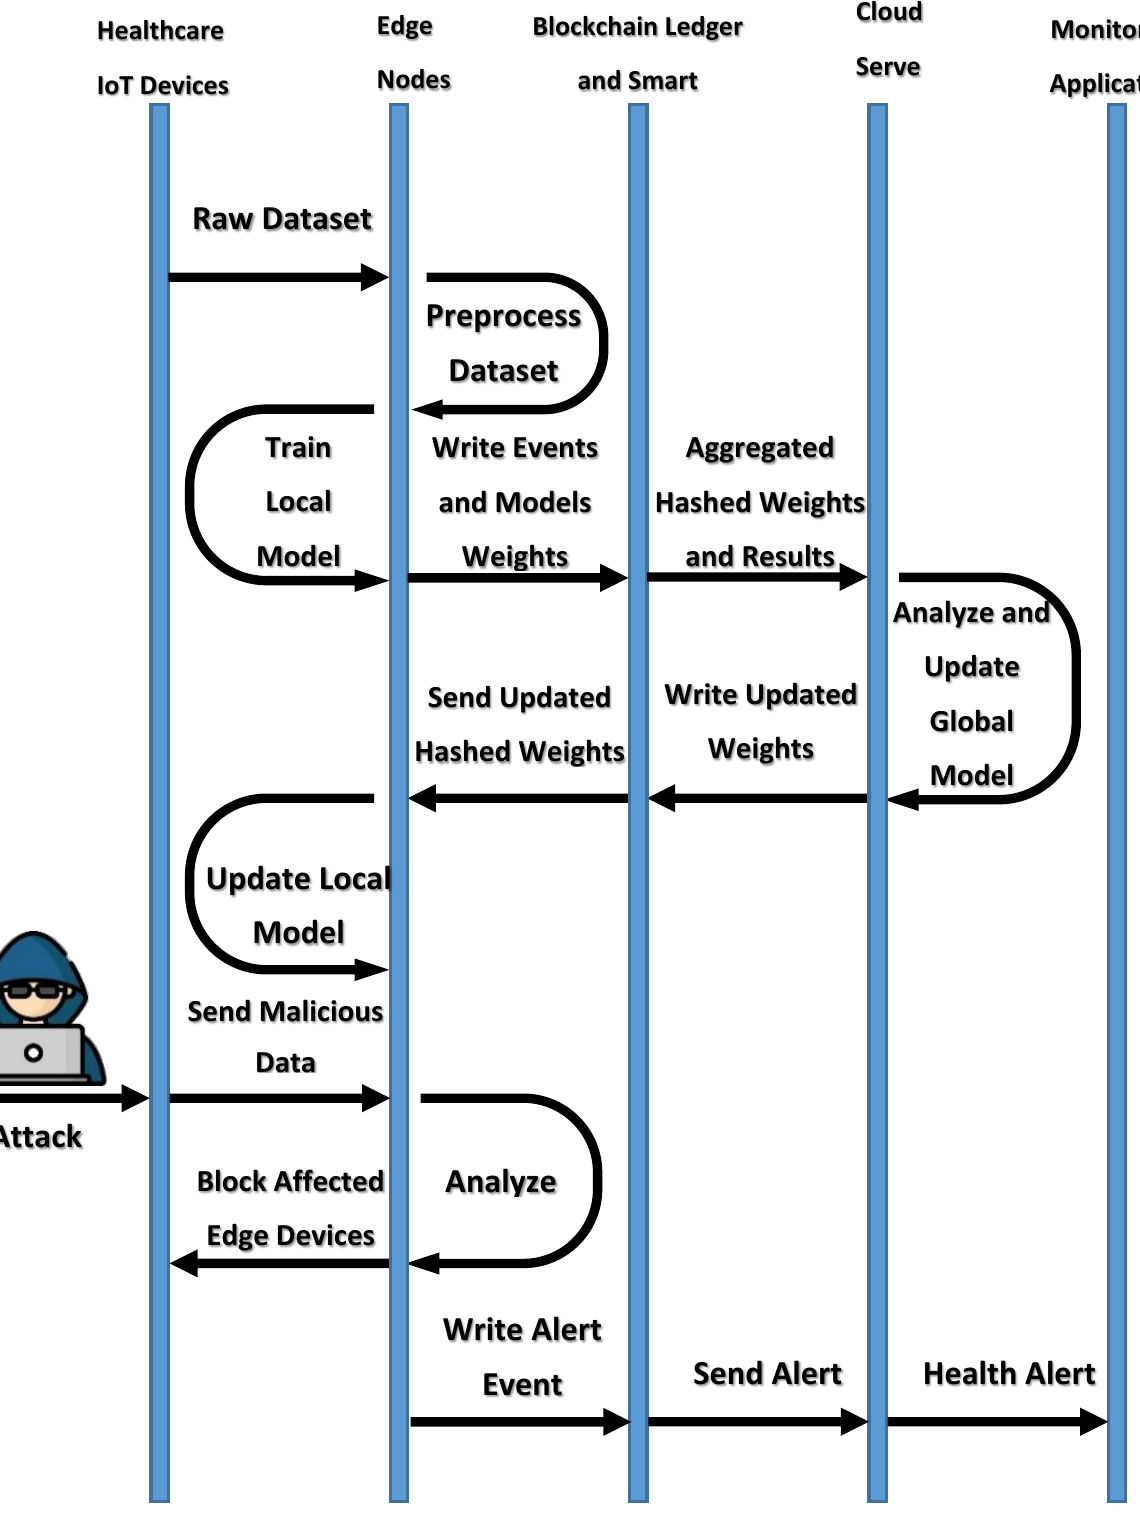
Figure 2. Flow execution of the proposed FIDChain system .